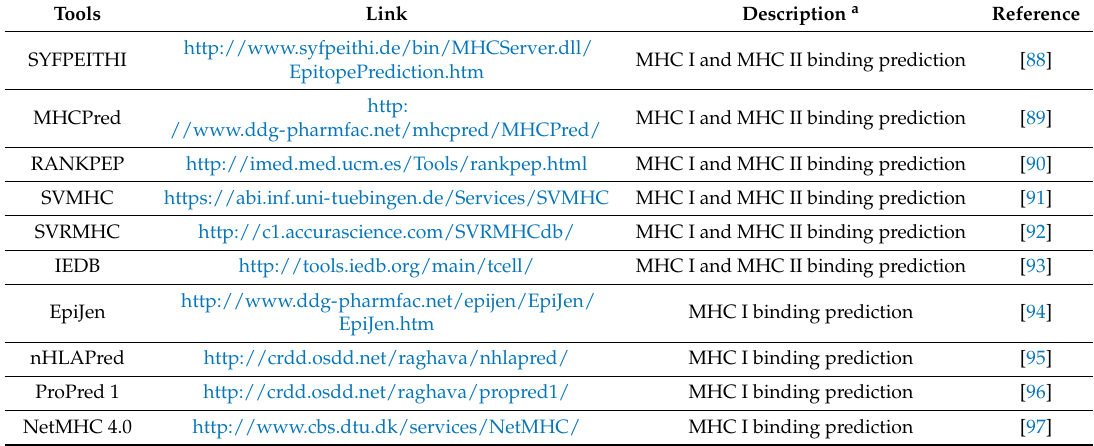
Table 2. Selected web tools for in silico T-cell epitope